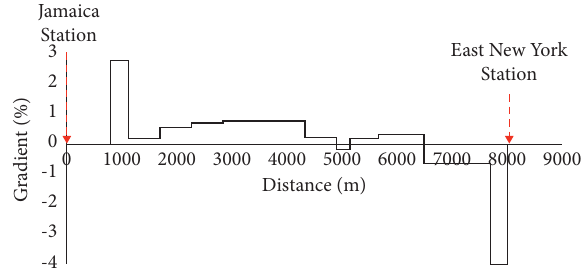
Figure 2: Alignment gradient vs. Table 1: Train specifications.